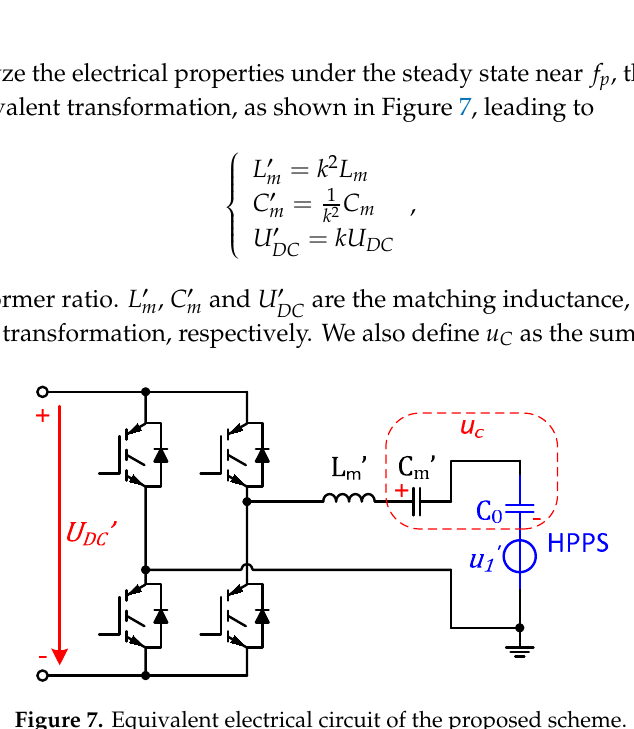
Figure 7. Equivalent electrical circuit of the proposed scheme.